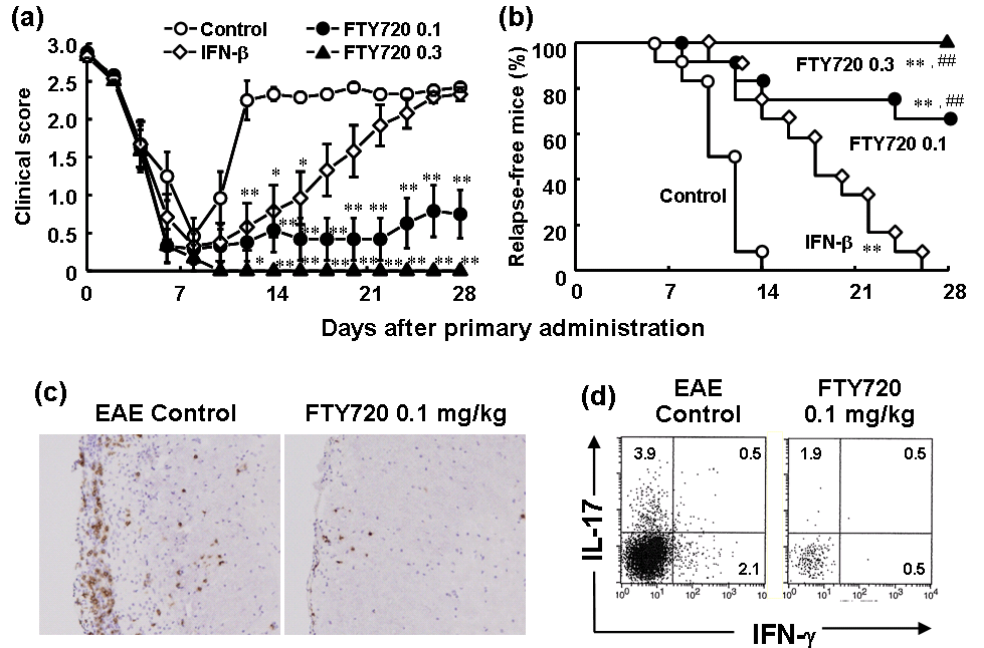
Figure 5. Therapeutic effects of FTY720 and rm-IFN- β on EAE induced by PLP in SJL/J mice [38]. SJL/J mice were immunized with PLP (50 μ g/mouse) and Freund’s 139–151 complete adjuvant. EAE-developed mice were divided into 5 groups on day 15 after immunization and were given FTY720 (0.1 and 0.3 mg/kg orally, everyday) or rm-IFN- β (10,000 IU/mouse subcutaneously, every other day) for 4 weeks. ( a ) Clinical scores are expressed as the mean ± S.E.M. of 12 mice. Statistical differences were calculated by Steel’s test (* p < 0.05, ** p < 0.01 versus control); ( b ) Mice remaining relapse-free. Statistical differences were calculated by generalized Wilcoxon test (** p < 0.01